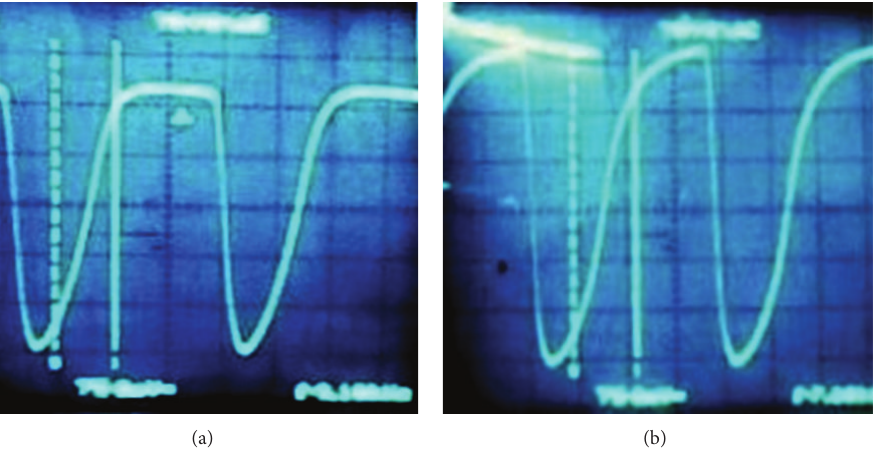
Figure 12: The response time as a function of the rise time. (a) (n-SnO 2 /n-Si) device, (b) (n-SnO 2 /p-Si) MIS